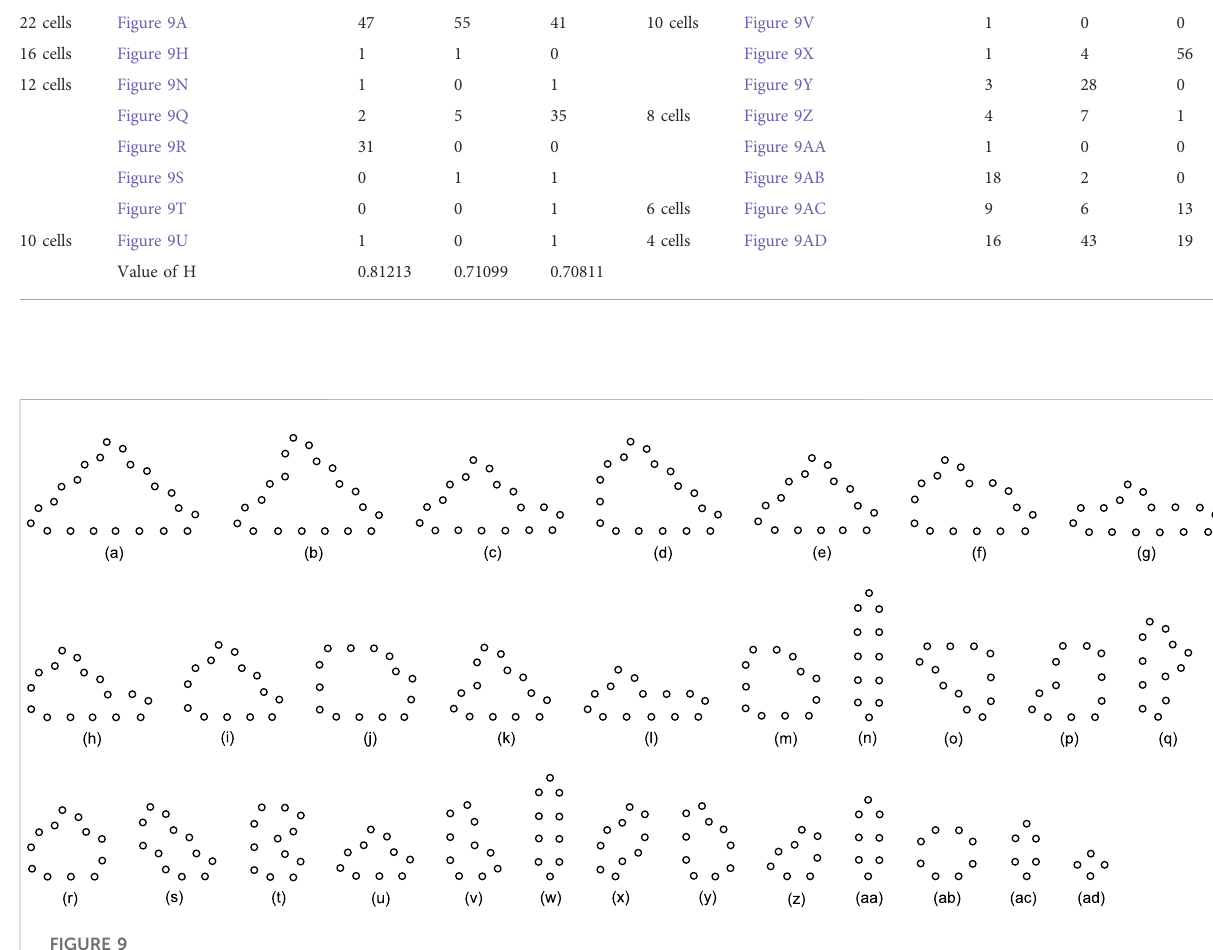
TABLE 7 Statistical numbers of the loops with various structures for the changing mechanism on different cellular spaces starting from the initial con fi guration in Figure 7B. Loop Size